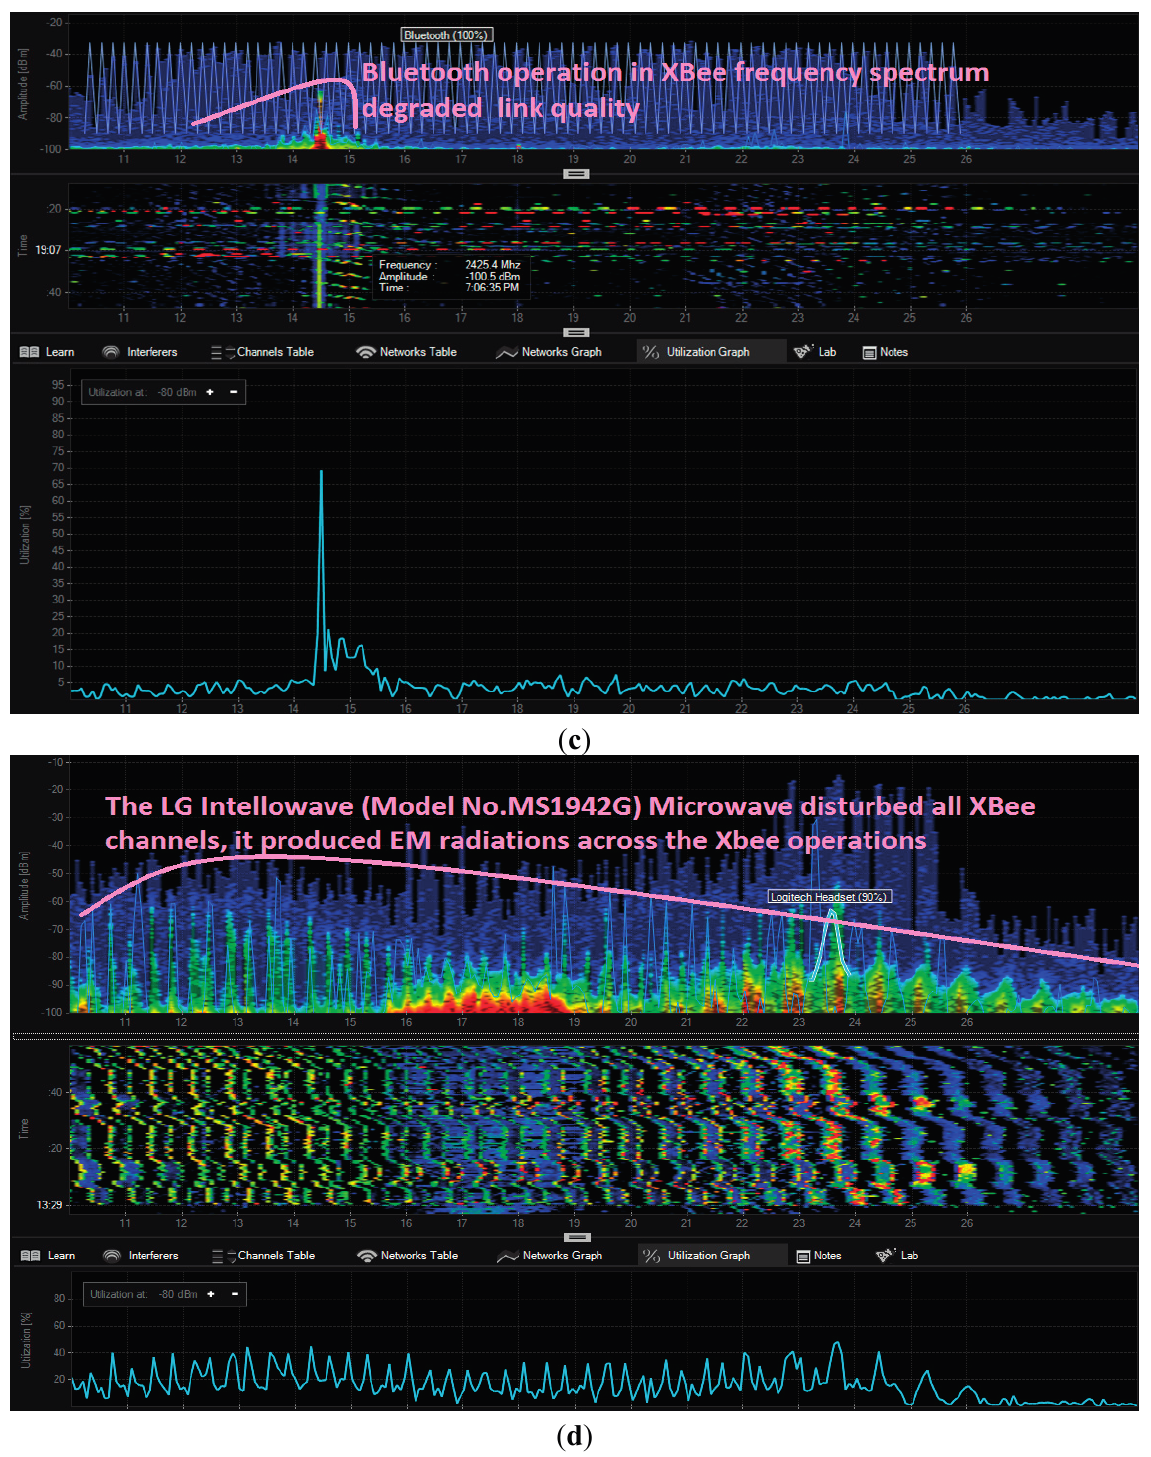
Figure 15. ( a ) shows the that the XBee smart building system is operating at frequency 2.425 MHz; ( b ) shows the Bluetooth functioning over the same frequency 2.425 MHz, which degraded the XBee RF link quality; ( c ) shows the Wi-Fi operation that affected the XBee operation badly; ( d ) Microwave oven distributed all ZigBee channels, and the microwave signal are dissipated across the whole ZigBee